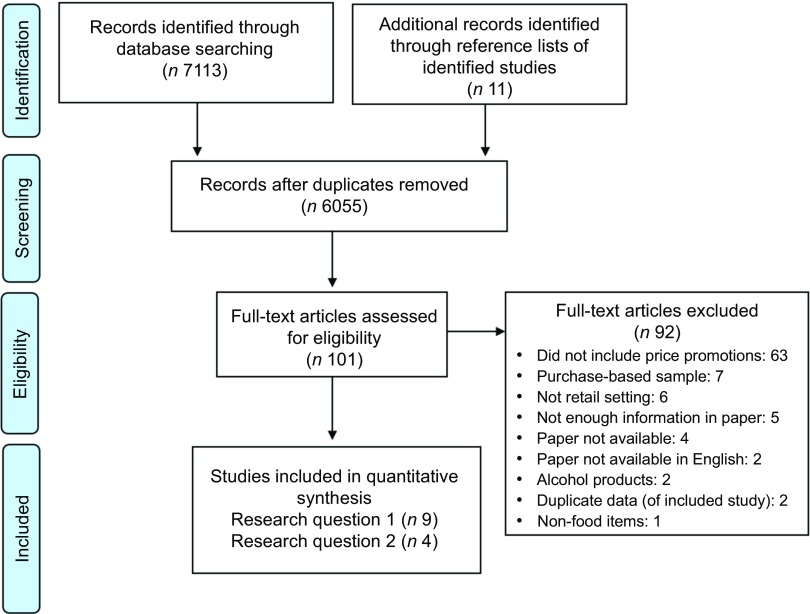
Prisma flow chart